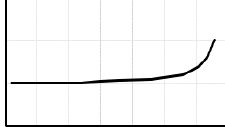
Figure 2. Template of the cantilever configurations in the sagittal view.